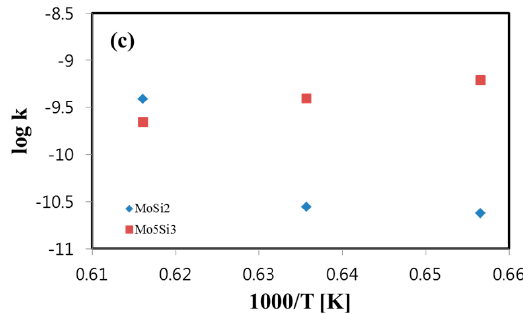
Figure 7. Layer kinetics of ( a ) MoSi 2 layer, ( b ) Mo 5 Si 3 layer during oxidation exposure with respect to the exposure time; ( c ) shows the log k vs. inverse temperature plot.